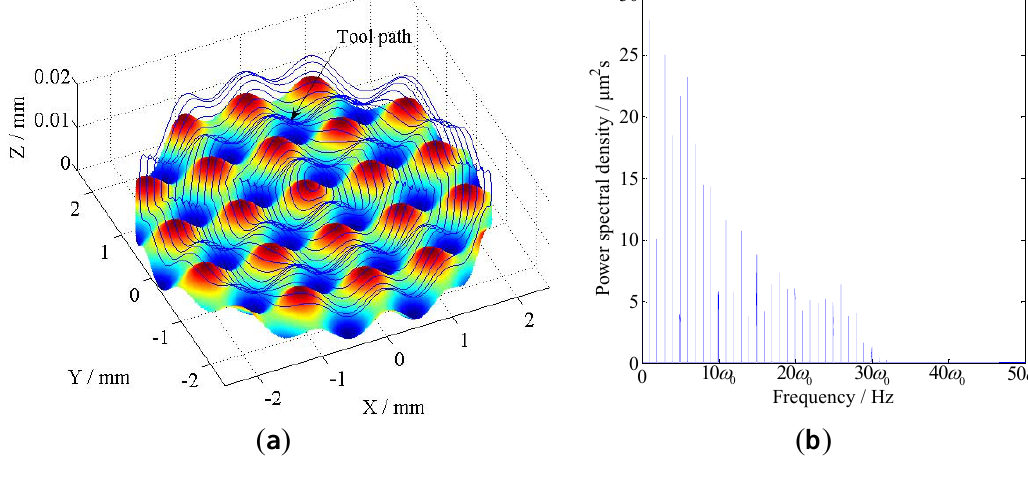
Figure 10. The sinusoidal grid surface and the PSD analysis of its tool path: ( a ) Schematic of the sinusoidal grid surface and its tool path; ( b ) PSD analysis of the tool